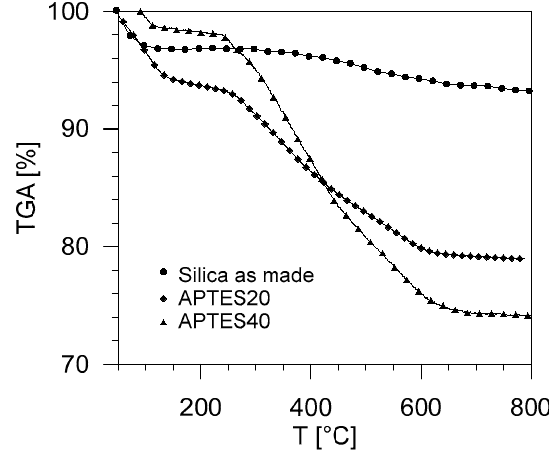
Figure 8. TGA analysis for the as-made silica, APTES20 and APTES40.